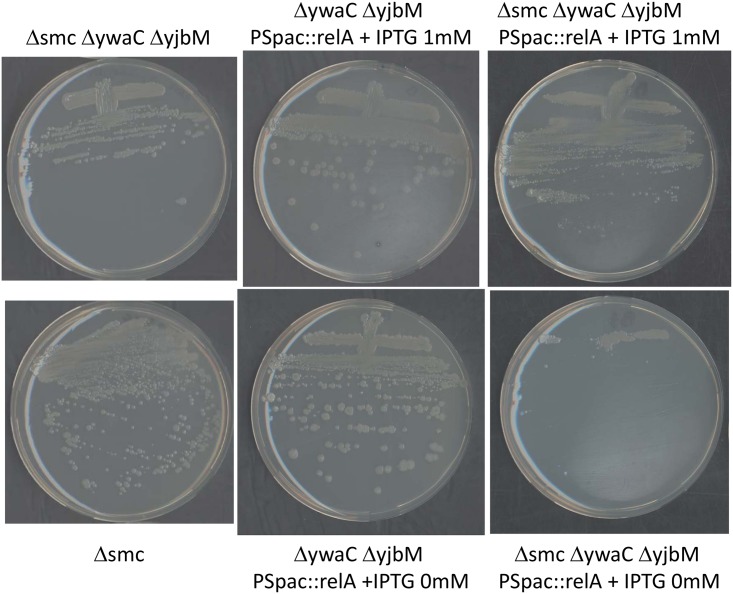
The (p)ppGpp synthase RelA is required for viability of SMC null mutant strains.A strain background was constructed in which the two minor (p)ppGpp synthases were inactivated (ΔywaC ΔyjbM) and expression of only remaining (p)ppGpp synthase activity was placed under control of the IPTG-inducible promoter (PSpac::relA). This strain formed isolated colonies on LB plates without and with IPTG 1mM at permissive temperature (23°C). However, in absence of SMC (Δsmc) in this background, IPTG was absolutely required to form isolated colonies. Note that only residual growth in the mass of the streak is observed without IPTG.